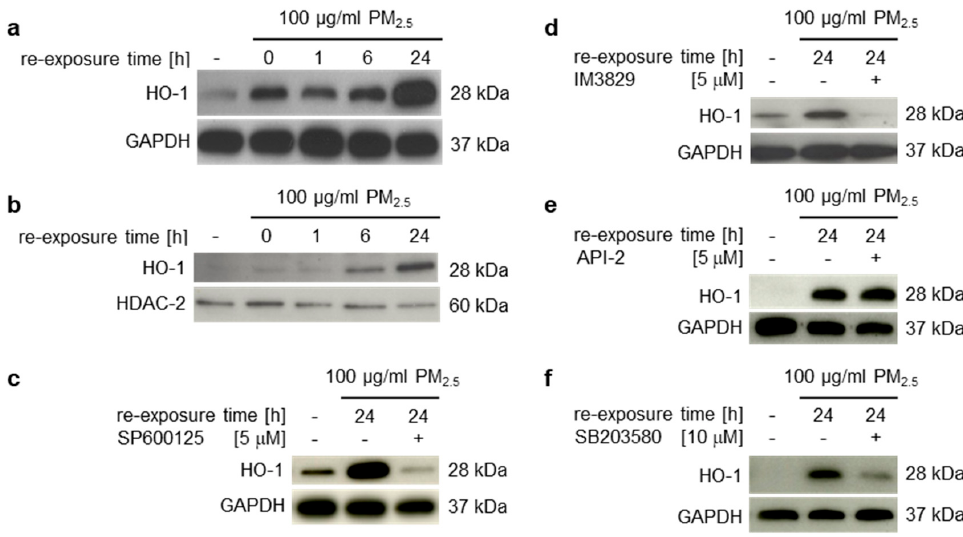
Figure 3. Long-term exposure to PM 2.5 induces HO-1 expression and nuclear translocation. BEAS-2B cells were cultured in the presence of 100 µ g / mL PM 2.5 for 3 to 5 weeks, before final passage and re-exposure to 100 µ g / mL PM 2.5 for the indicated time points (0–24 h). The JNK inhibitor SP600125 (5 µ M), the Nrf2 inhibitor IM3829 (5 µ M), the Akt inhibitor API-2 (5 µ M), or the p38 inhibitor SB203580 (10 µ M) were added 1 h prior to the last PM 2.5 re-exposure. ( a , c – f ) Total amounts of HO-1 were detected by immunoblotting in non-fractionated total cell lysates and normalized to GAPDH. ( b ) Translocated HO-1 was immunodetected in nuclear extracts and normalized to HDAC-2. Cells, cultured in the absence of PM 2.5 served as controls (first lane). Inhibition of JNK1 / 2 or p38 decreased HO-1 expression. Representative blots of three di ff erent experiments are shown, except of ( b ) (n =